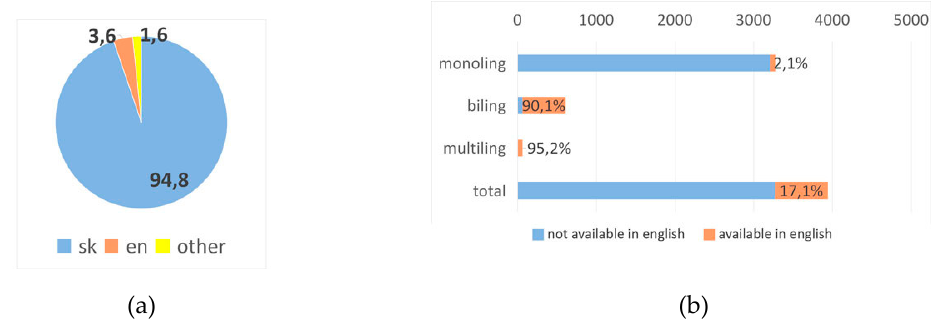
Figure A24. Visualization of the results for domain sk. ( a ) Primary languages pie chart and ( b ) English